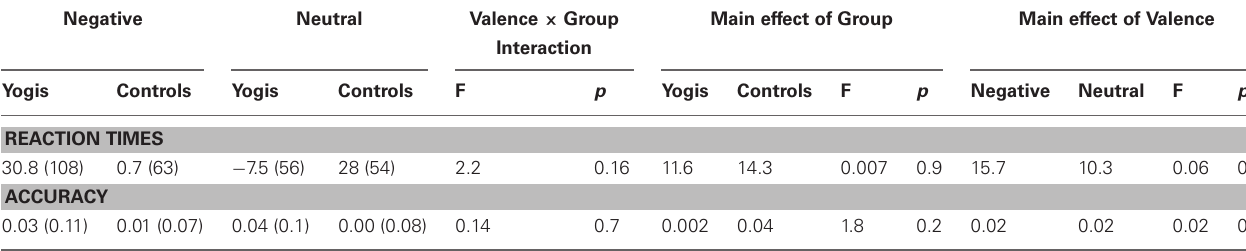
Table 2 | Affective Stroop task: behavioral stroop performance (incongruent-congruent).